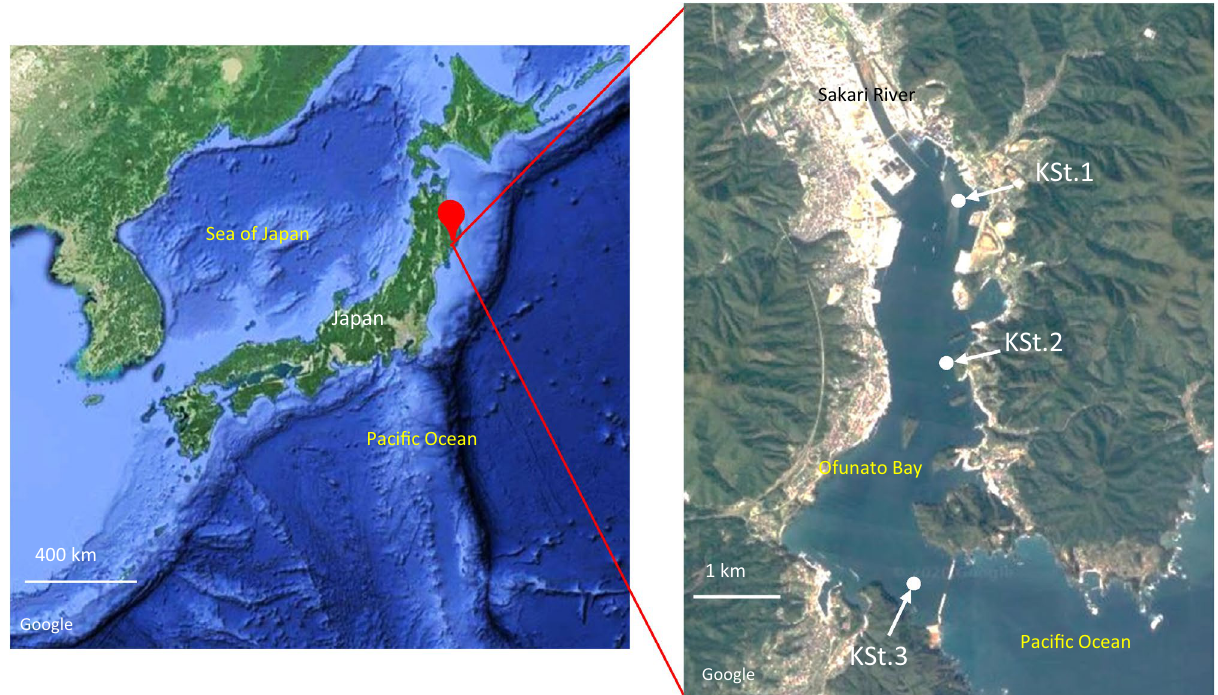
Figure 1. Maps showing stations for seawater sample collection in Ofunato Bay, Iwate Prefecture, Japan. KSt. 1 (innermost area; 141.73245 E, 39.063370 N; average depth, 10.3 m), KSt. 2 (middle area; 141.73254 E, 39.044612 N; average depth, 25.3 m) and KSt. 3 (bay entrance area; 141.72820E, 39.019030 N; average depth, 38.5 m) are marked with arrows. The bay is 6 km in length and 1.5 km in width, with a maximum depth